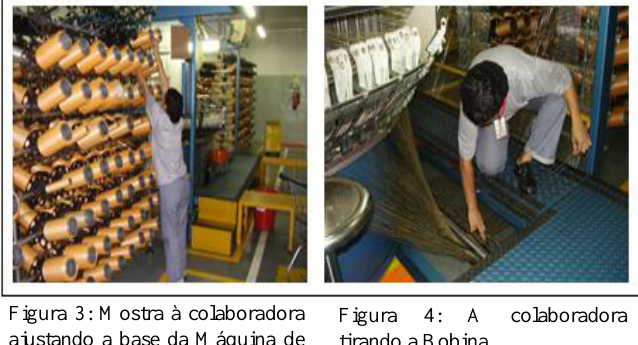
Figura 3: Mostra à colaboradora Figura colaboradora ajustando a base da Máquina de tirando a Tecelagem Circular.